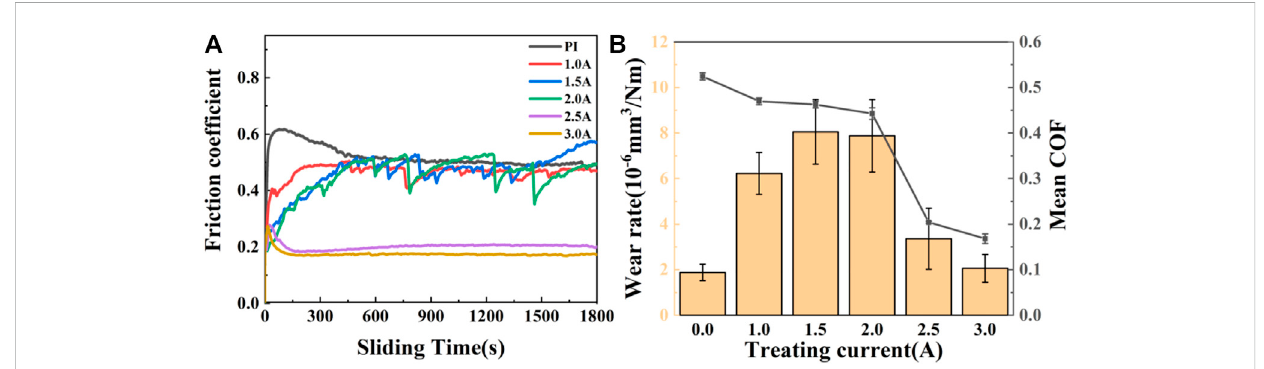
FIGURE 8 The friction coef fi cient of the PI substrates treated with different graphite target currents with a 2N load: (A) the friction coef fi cient curve (B) the average friction coef fi cient and the wear rate.